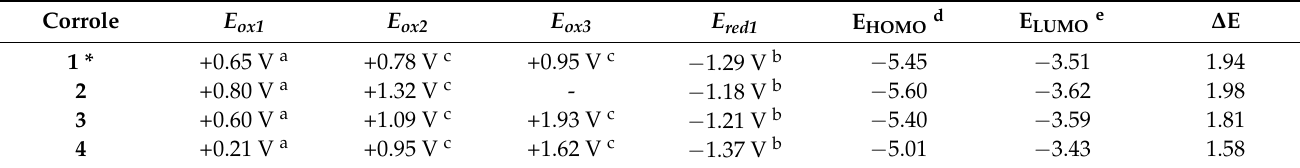
Table 3. Redox potentials of corroles 1 – 4 in dry DCM solution ( E versus SHE).